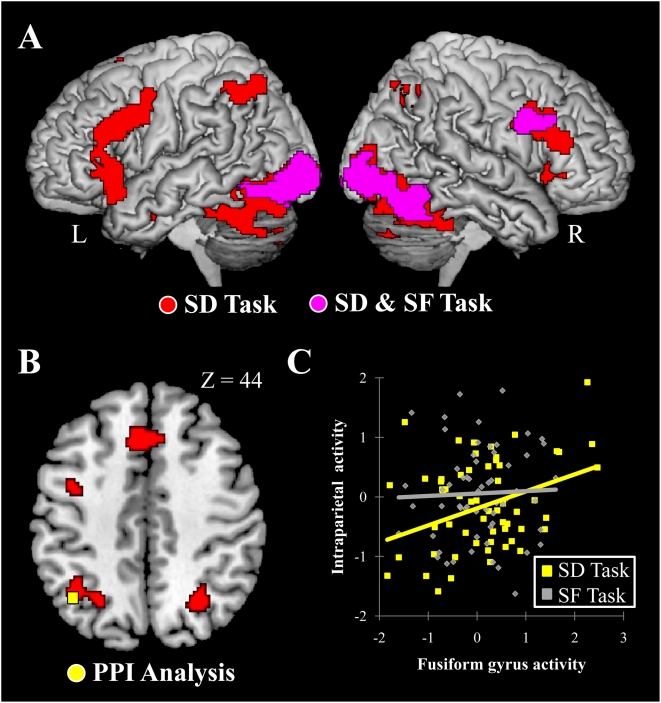
Brain activations during SD and SF (A), and results from PPI analysis (B, C).(A) Pink sections indicate brain regions active in common between in the SD and SF tasks, [Boolean intersection (SD vs. SC) ∩ (SF vs. SC) for display purpose]. Red sections indicate brain regions active during the SD task (SD vs. SC). While many regions active during the SD task were also active during the SF task, parietal activations were observed only in the SD task. The right hemisphere is displayed in the right panel. (B) The yellow section is a parietal region whose activity enhanced its coupling with that in the left fusiform region only in the SD task. Horizontal section z = +44 is displayed. C, Relationship between activities of the left fusiform gyrus and the left intraparietal cortex in a representative participant [N = 60, r = 0.33, p<0.01 for the SD task (yellow dots); r = 0.01, p>0.93 for the SF task (grey dots)]. X-axis indicates the degree of activity (mean adjusted) in each trial of the fusiform gyrus, and Y-axis indicates that of the intraparietal cortex.